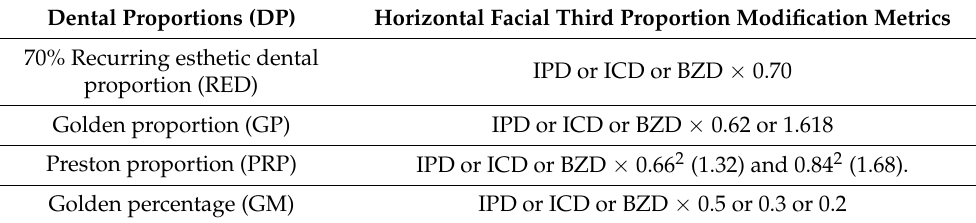
Table 1. The distribution of modification metrics used to determine the inter-canine distance and central incisors’ width. Dental Proportions (DP) Horizontal Facial Third Proportion Modification